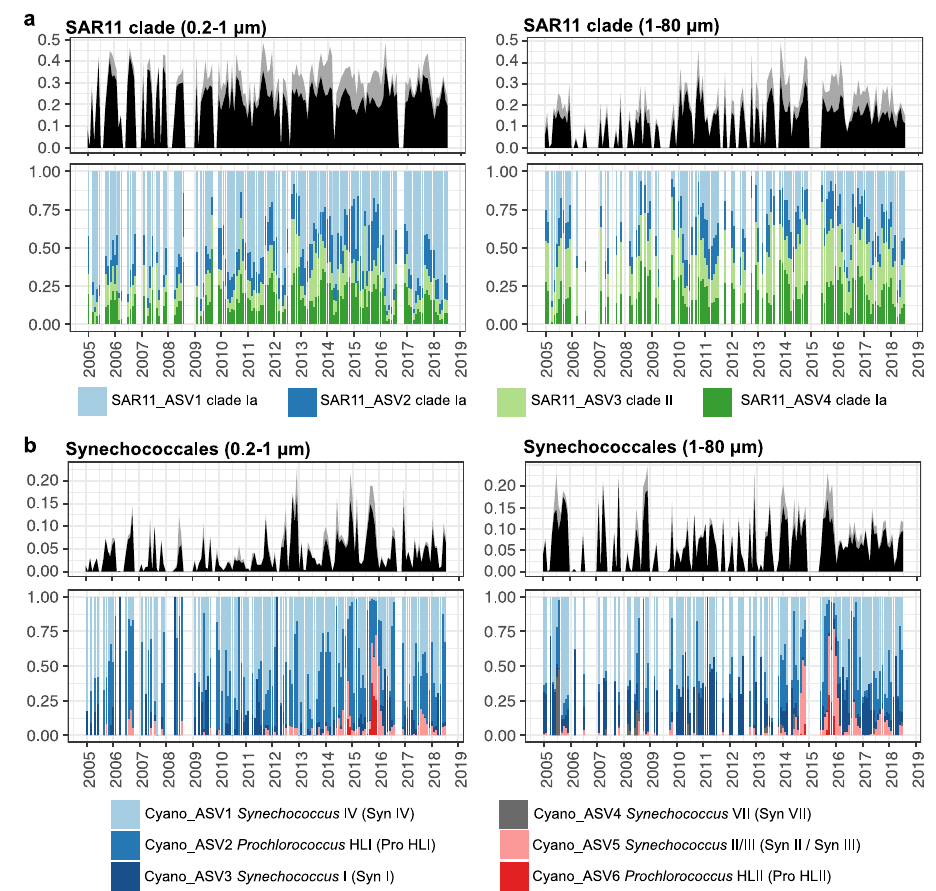
Fig. 6 | Relative abundance of major ASVs within SAR11 and Synechococcales cyanobacteria. GrayareasinthetopgraphsrepresentrarerASVsofthecladesnot speci fi cally included in the lower graphs. Note the appearance of Prochlorococcus